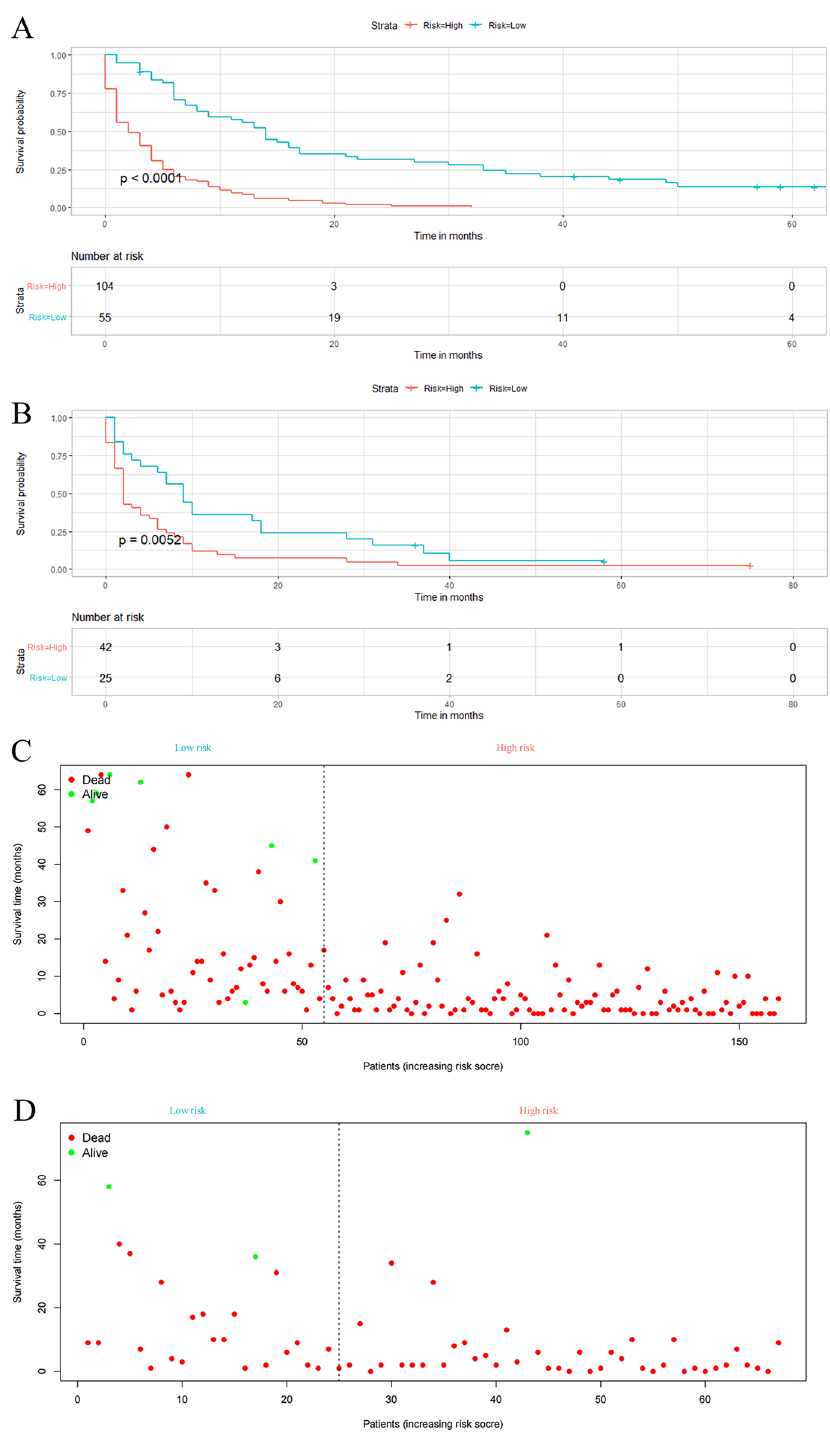
Figure 8. Risk stratification for PC patients with BM. Survival curve of two risk groups in the training set ( A ) and validation set ( B ); a scatter diagram to show the survival status of patients in the training set ( C ) and validation set ( D